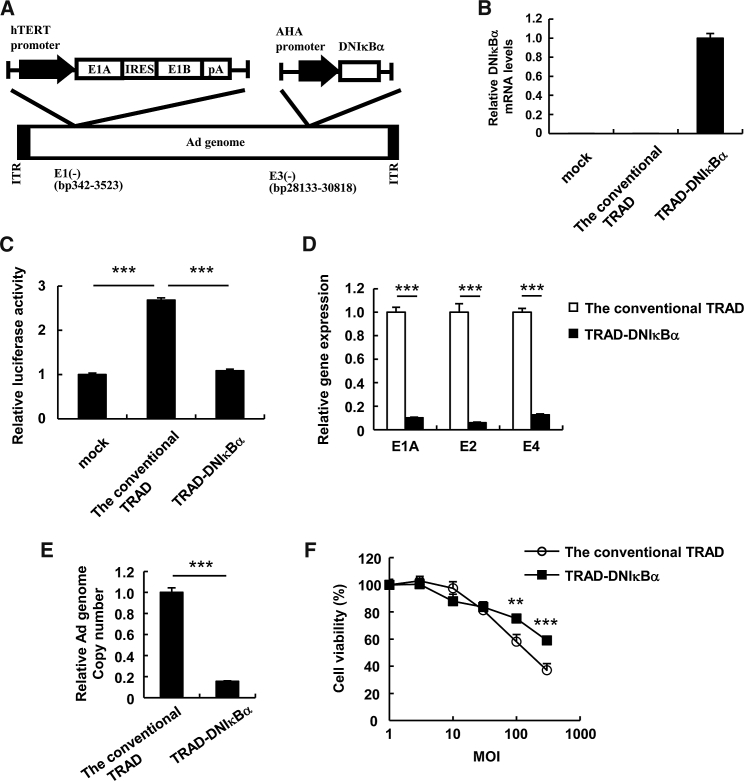
Suppression of Ad Gene Expression and TRAD Replication by the Expression of a Dominant-Negative IκBα in Hepatocytes(A) A schematic diagram of TRAD showing a liver-specific expression of DNκBα (TRAD-DNIκBα). (B) PH5CH8 cells were infected with the conventional TRAD or TRAD-DNIκBα at an MOI of 5. After 48-hr incubation, the DNIκBα mRNA levels were determined by qRT-PCR analysis. (C) PH5CH8 cells were transfected with pNF-κB-Luc, followed by infection with the conventional TRAD or TRAD-DNIκBα at an MOI of 5. After 48-hr incubation, luciferase activity was determined. The data show FLuc activity normalized by RLuc activity in the cells. (D and E) PH5CH8 cells were infected with the conventional TRAD or TRAD-DNIκBα at an MOI of 5. After 48-hr incubation, the E1A, E2, and E4 mRNA levels (D) and the copy numbers of TRAD genomic DNA (E) in the cells were determined by qRT-PCR and qPCR analyses, respectively. (F) PH5CH8 cells were infected with the conventional TRAD or TRAD-DNIκBα at the indicated MOI. After 5-day incubation, cell viability was determined by alamarBlue assay. The data were normalized by the data of the mock-infected group. Data are the means ± SD (n = 3–4). **p < 0.01; ***p < 0.001. AHA promoter, a liver-specific apolipoprotein E enhancer-hepatocyte control region-human a1-antitripsin promoter; DNIκBα, a dominant-negative IκBα; hTERT promoter, a human telomerase reverse transcriptase promoter; IRES, internal ribosome entry site; pA, bovine growth hormone (BGH) poly-adenine sequence.